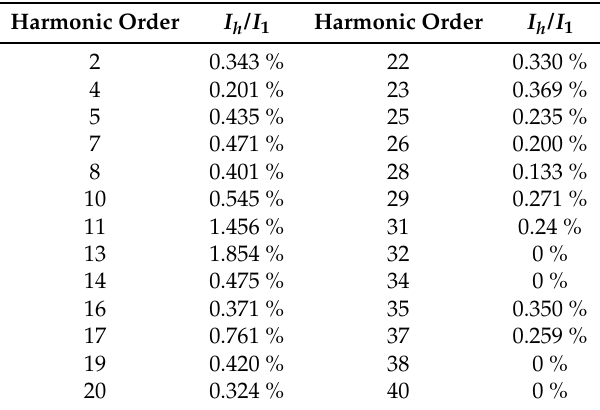
Table A1. Harmonic magnitudes of